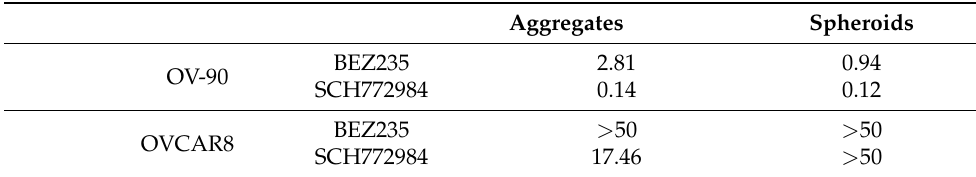
Table 2. Table of EC 50 values ( µ M) for BEZ235 and SCH772984 against OV-90 and OVCAR8 forced suspension aggregates and hanging drop